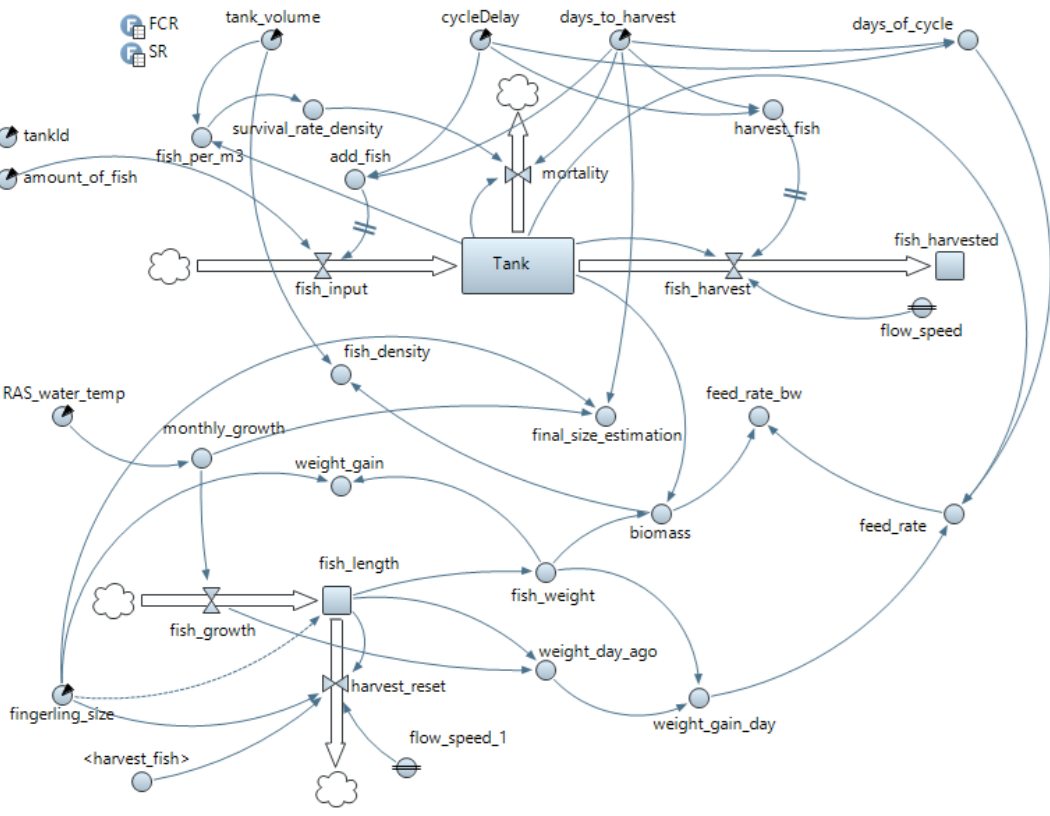
Figure A1. Software diagram of one fish tank of the RAS part of the AnyLogic model. The feed rate is linked to the total feed rate in Figure A2.